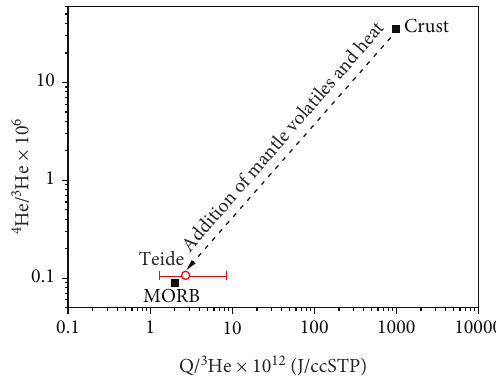
Figure 8: Schematic representation of the coherence between heat and